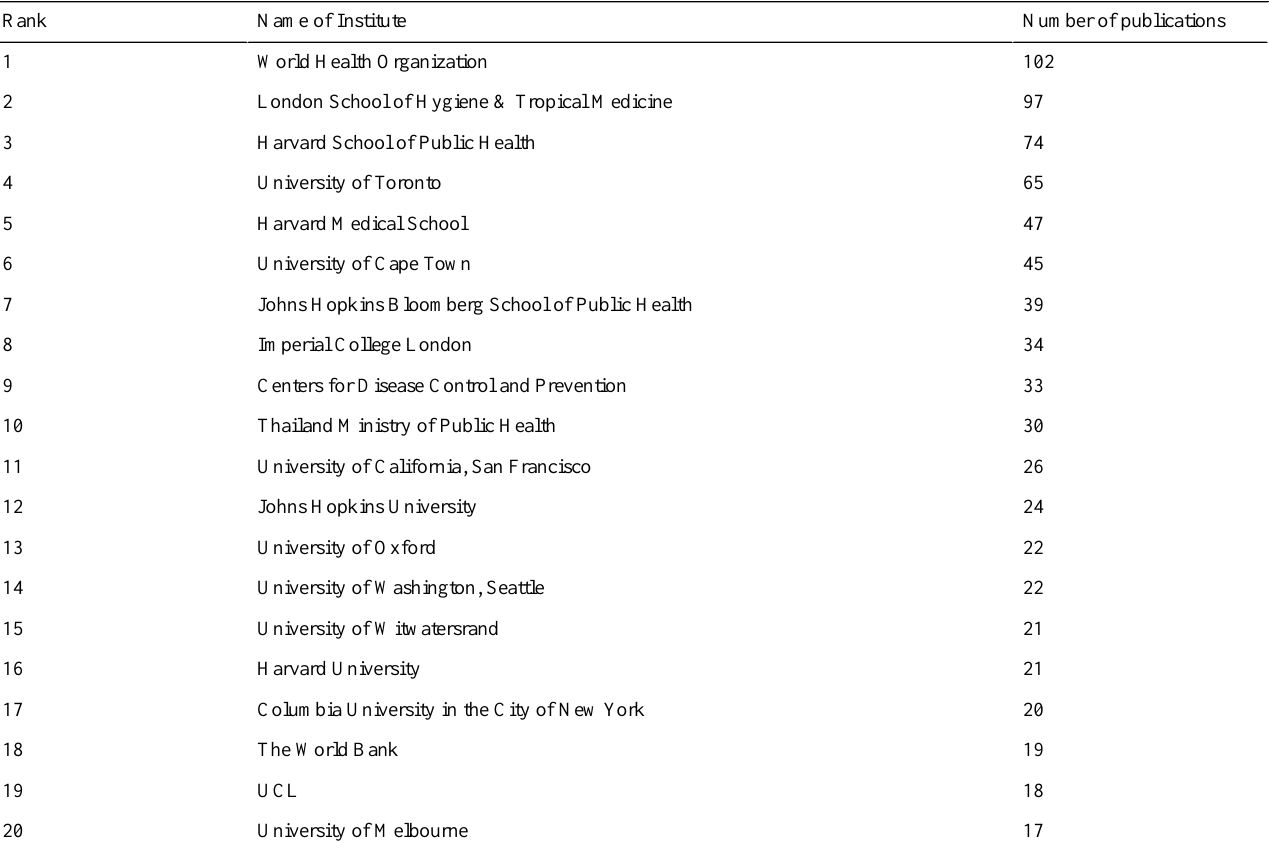
Table 4. Most active funding sources for universal health coverage (UHC)-related